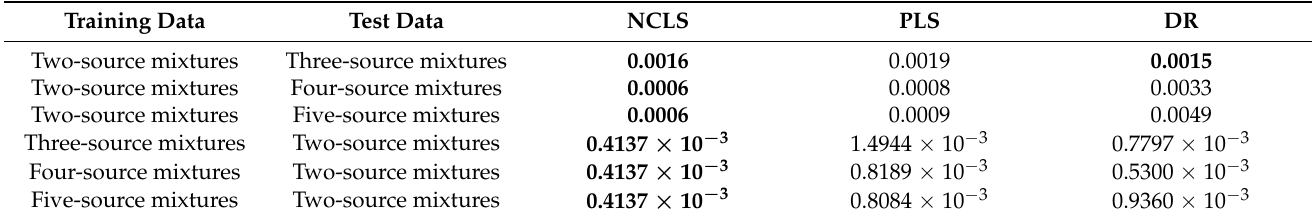
Table 6. Robustness analysis results for “low-mixing-rate mixture” dataset (Mixing-rate range used for